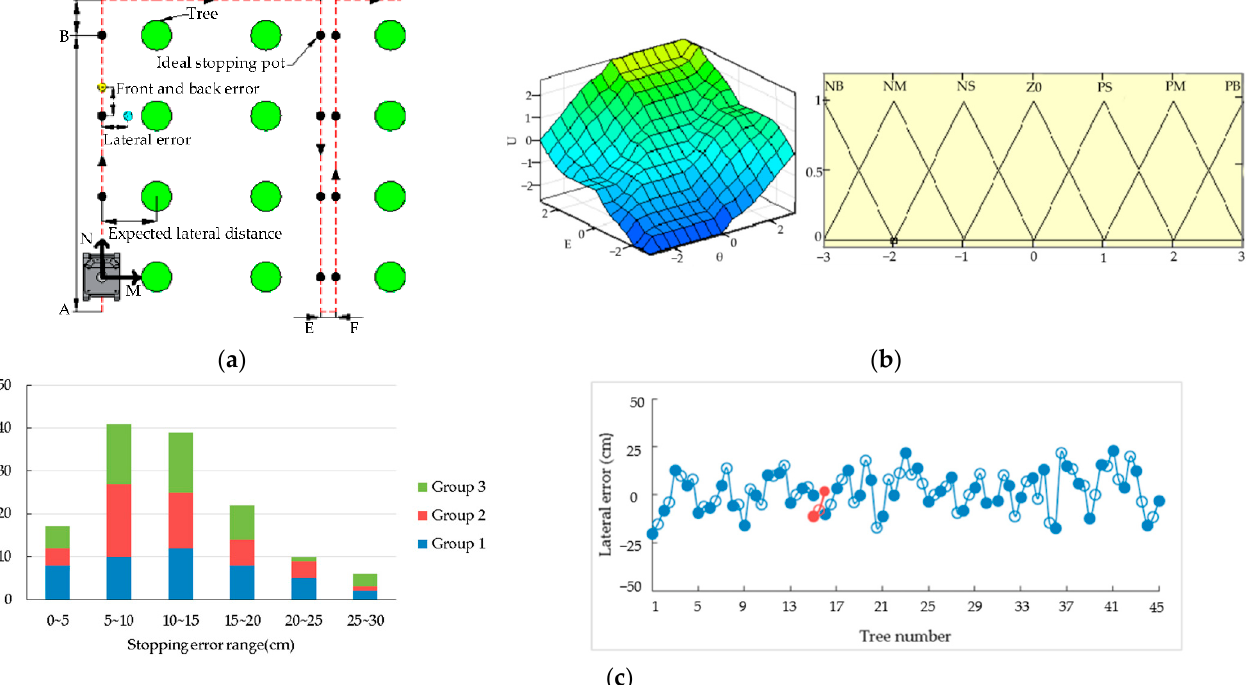
Figure 12. ( a ) Diagram of navigation paths used in tapping robot tasks [73] ; ( b ) diagram of fuzzy control rules (left) and the distribution of the membership function (right) [73] ; ( c ) distribution of stopping error and lateral error [73] .